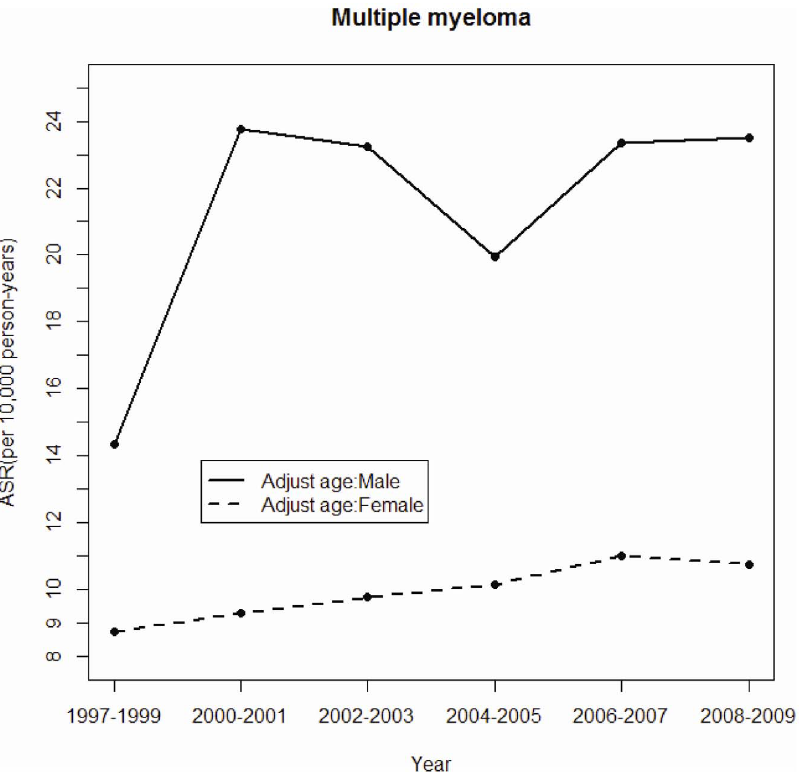
Figure 3. Gender-specific age-adjusted incidence of multiple myeloma for the period of 1997–2009.